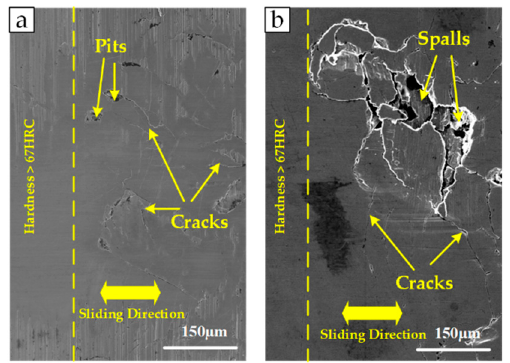
Figure 7. Worn Surfaces of LHAGI and LHQTGI Specimens: ( a ) 232 ° C; ( b ) 316 ° C.